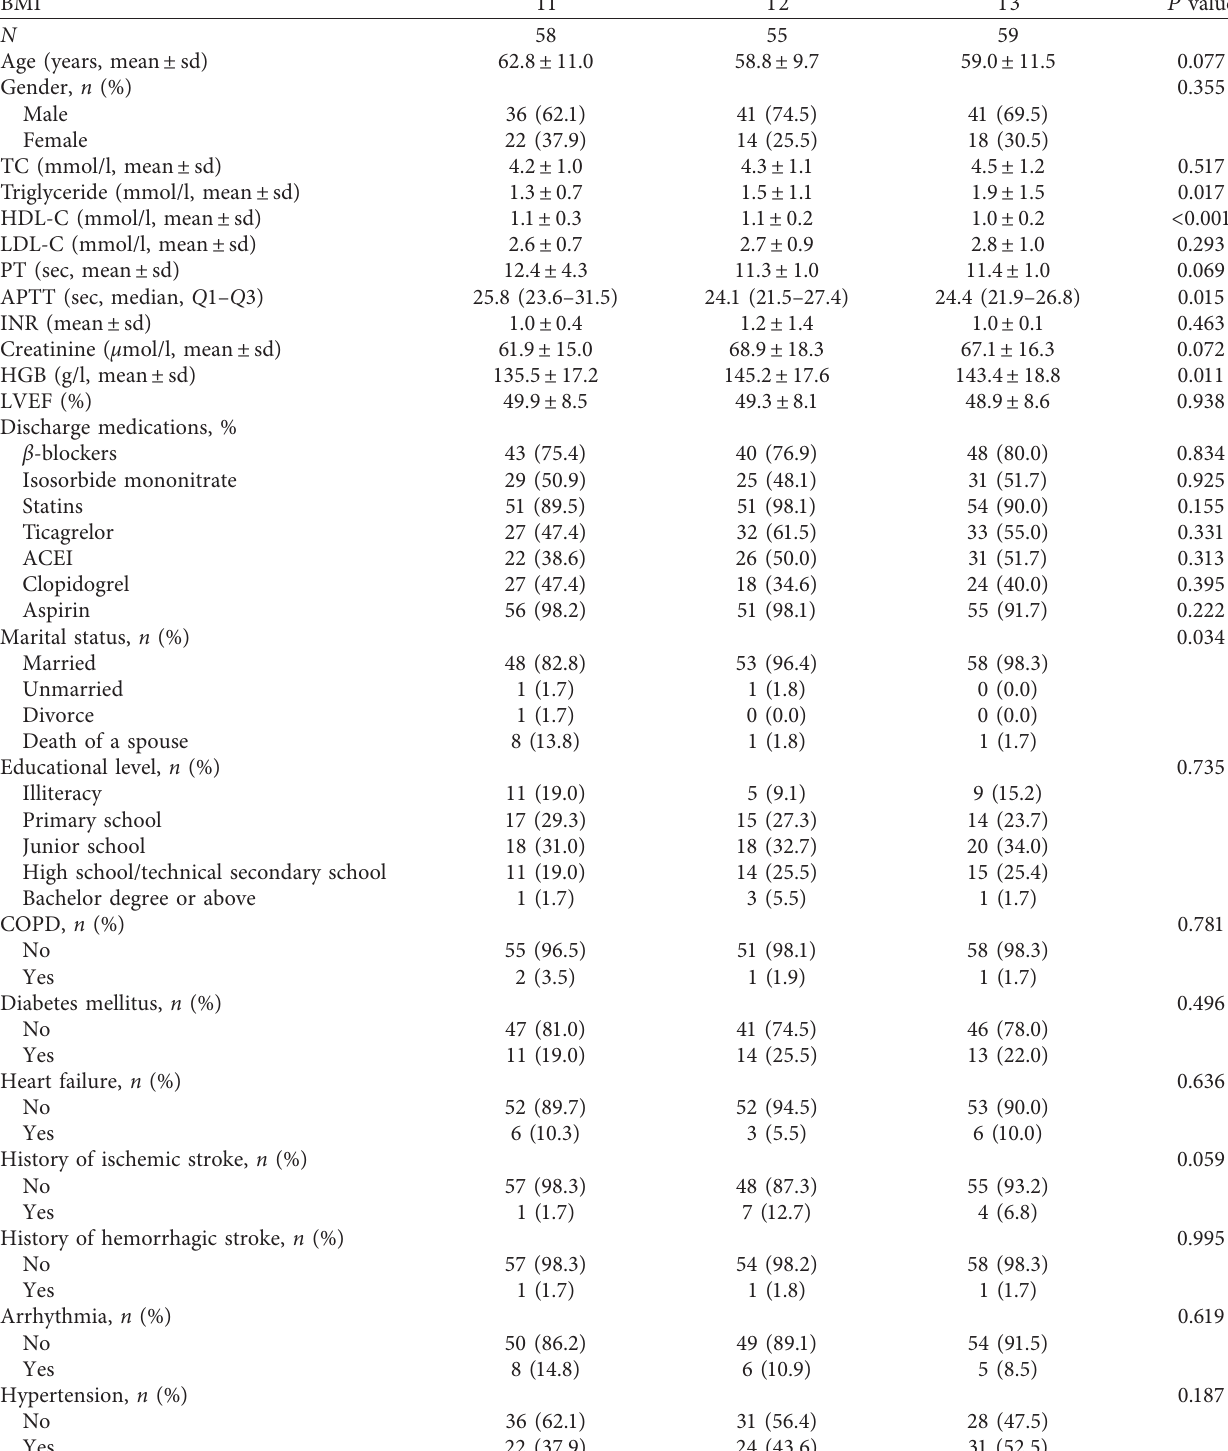
Table 1: Baseline characteristics of